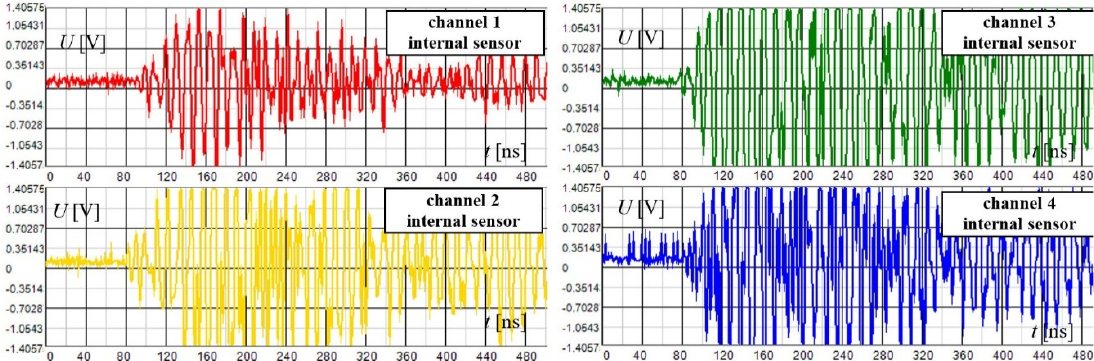
Figure 19. The waveforms of the disturbing signal acquired within the standard detection mode using 4 internal sensors.